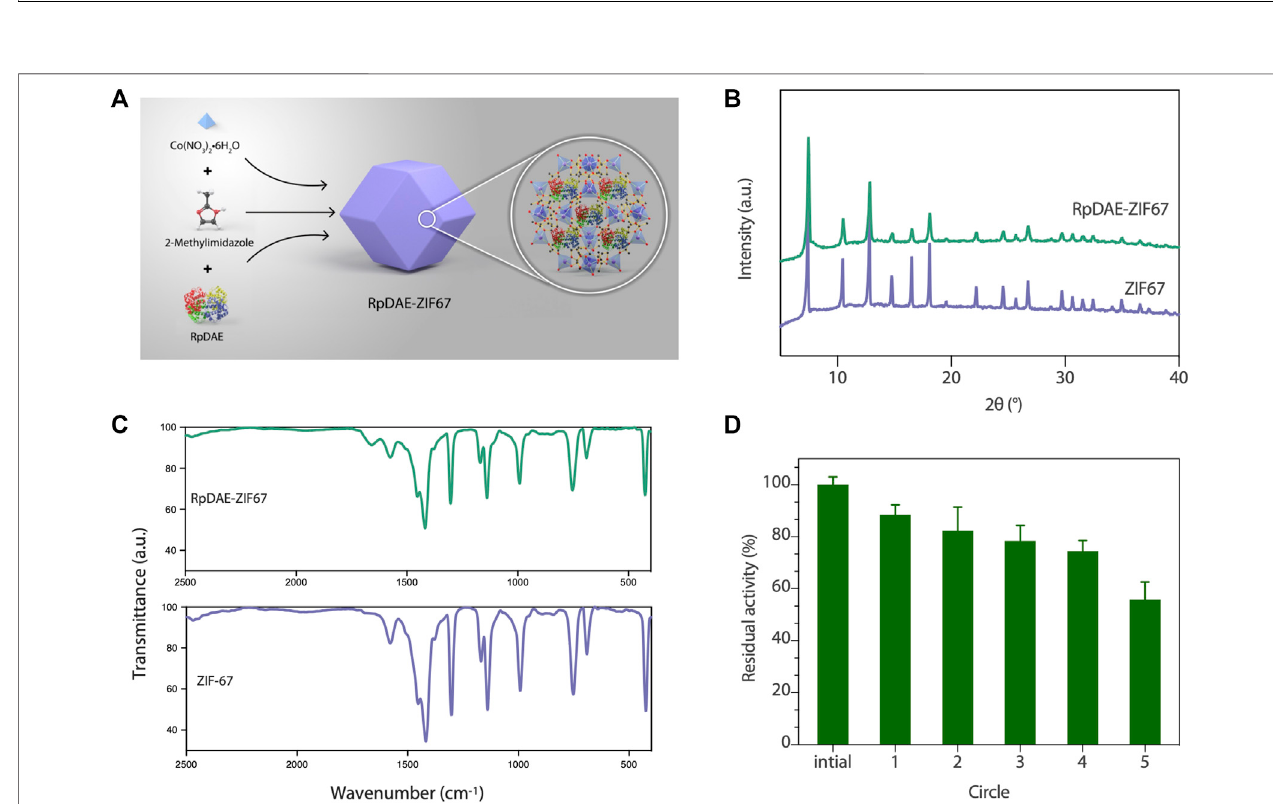
Frontiers in Bioengineering and Biotechnology |